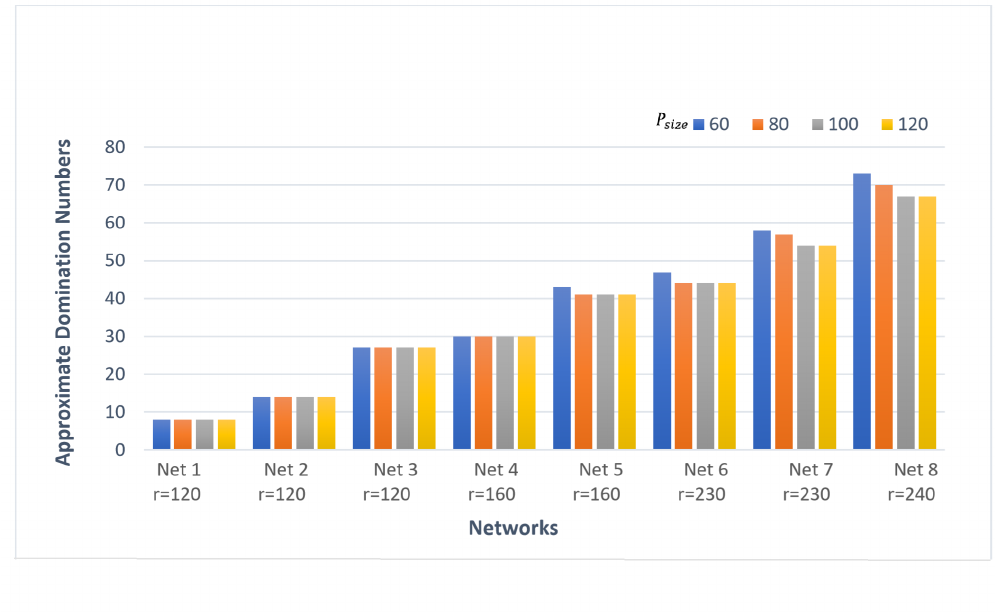
Figure 2. The performance of the ASS-MCDS with different P Size values.